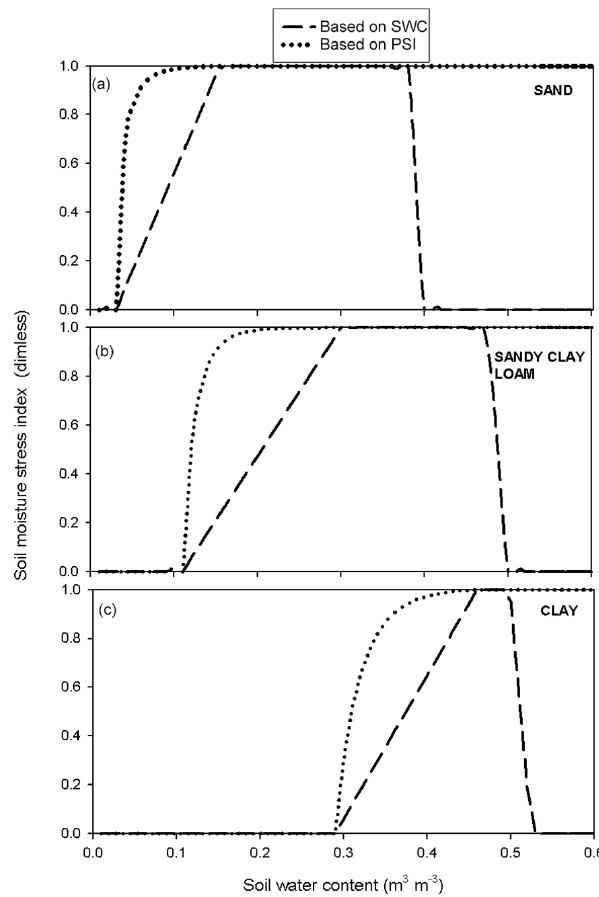
Figure 2. Dependence of the soil moisture stress index on soil water content for three different soil types: sand (a) , sandy clay soil (b) , and clay (c) . Soil stress index based on soil water potential (dotted lines) is used by the original model, while soil stress index based on normalized soil water content is used by BBGCMuSo (dashed